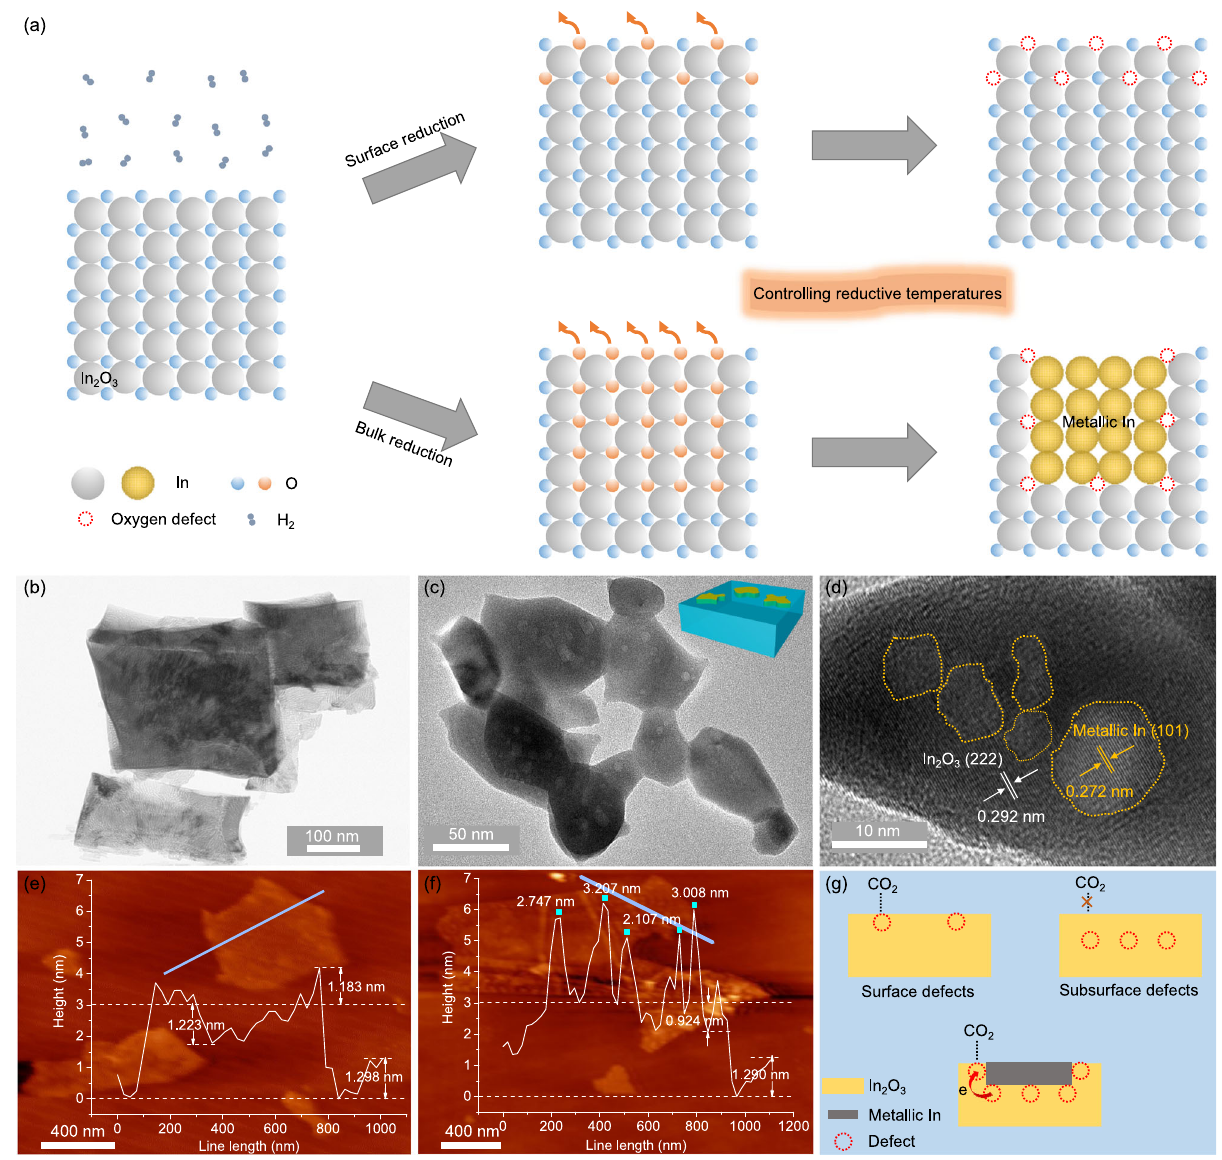
Fig. 1 Structure/morphology. a Schematic temperature-dependent surface reconstruction. TEM images of ( b ) In 2 O 3 and ( c ) In-Em In 2 O 3 . d HRTEM image of In-Em In 2 O 3 . AFM images of ( e ) In-Em In 2 O 3 and f In 2 O 3 with metallic In nanoparticles loaded on the surface (Inset: the height along the blue line). g Scheme of three types of oxygen